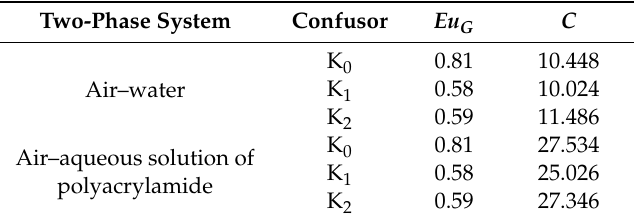
Table 1. Constants C and Eu G in Equation (7).